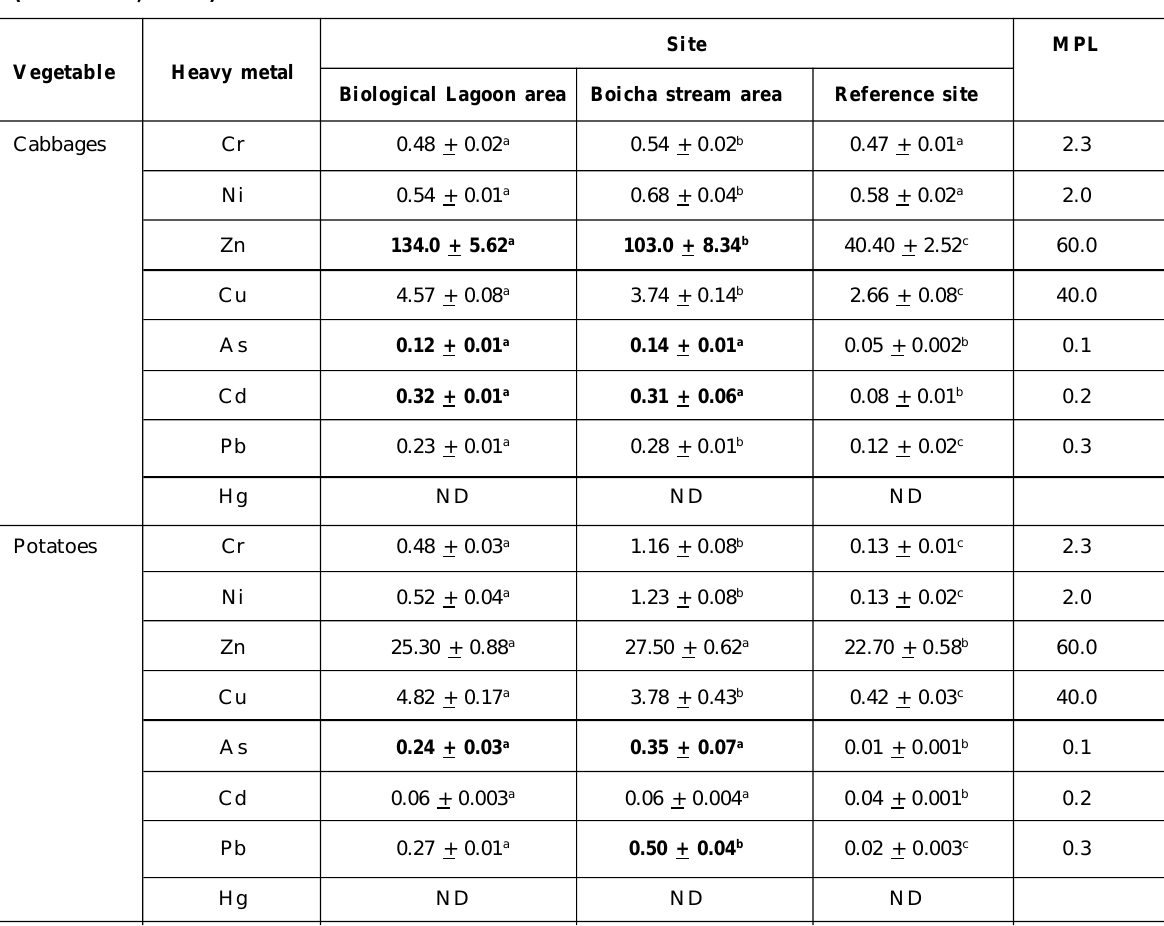
Table 1: Heavy metal concentrations (mg/kg, dry weight) in the cabbages and potatoes from the study sites (Mean ± SD, n = 10)